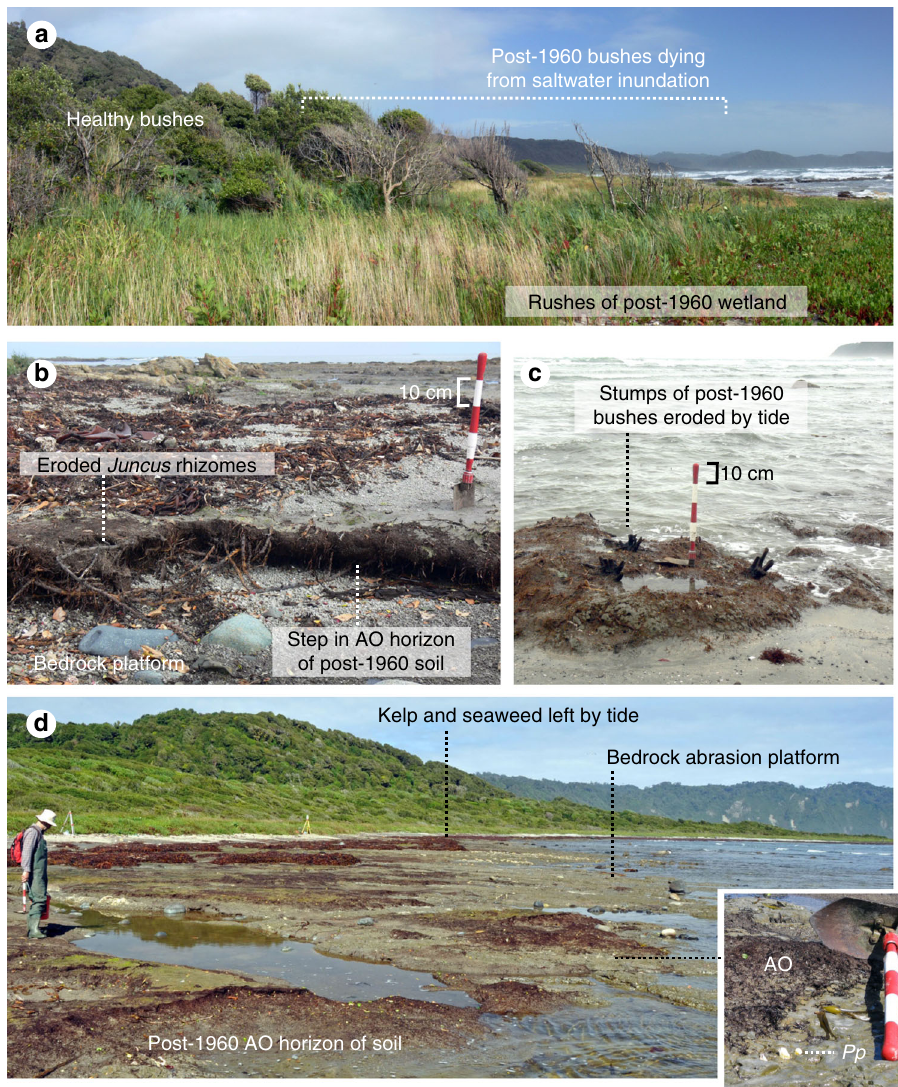
Fig. 3 Evidence for post-1960 subsidence at Caleta Rica. a Post-1960 Luma apiculata bushes dying due to saltwater inundation adjacent to healthy rushes ( Juncus sp.) in post-1960 marsh. Higher bushes in background are healthy. b Step in peaty AO horizon of post-1960 soil containing Juncus rhizomes. Soil developed directly on abrasion platform of Tertiary bedrock. c Stumps of post-1960 Luma apiculata bushes in growth position eroded by tides in the present intertidal zone. d View of Tertiary bedrock platform with remains of post-1960 wet meadow soil eroded by tides. Inset shows in situ shells of Petricola patagonica ( Pp ), a bivalve borer, exhumed from the post-1960 soil by tidal erosion. The shells died following coseismic uplift in 1960 and were covered by the fi brous AO horizon of the soil, which protected them from erosion. Photos by D.